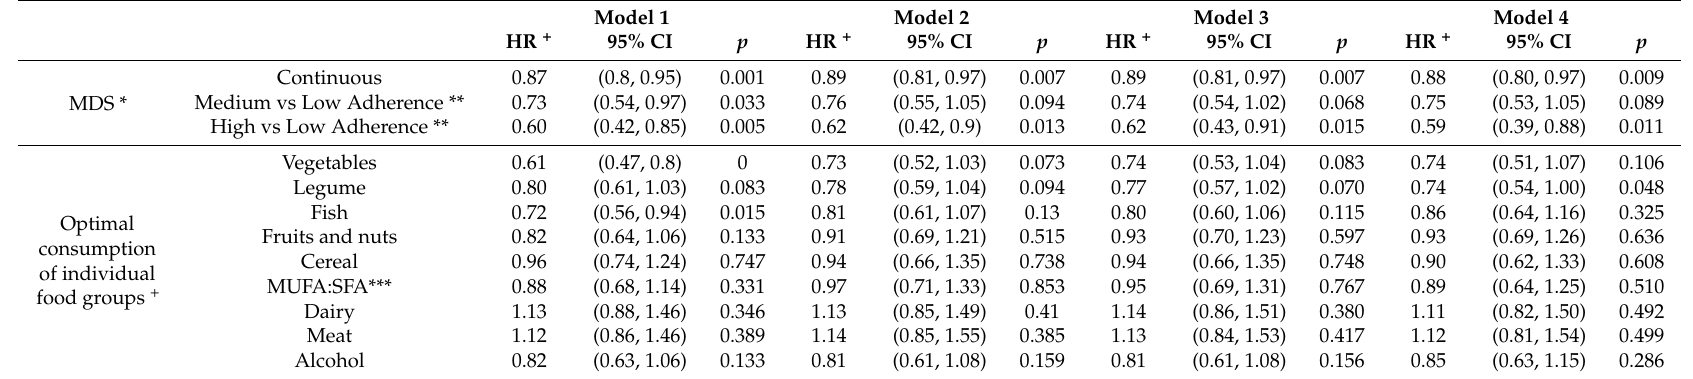
Table 2. Longitudinal associations between Mediterranean Diet Score and its components at baseline and cognitive decline after a follow-up of 18 y among InCHIANTI participants 65 y and